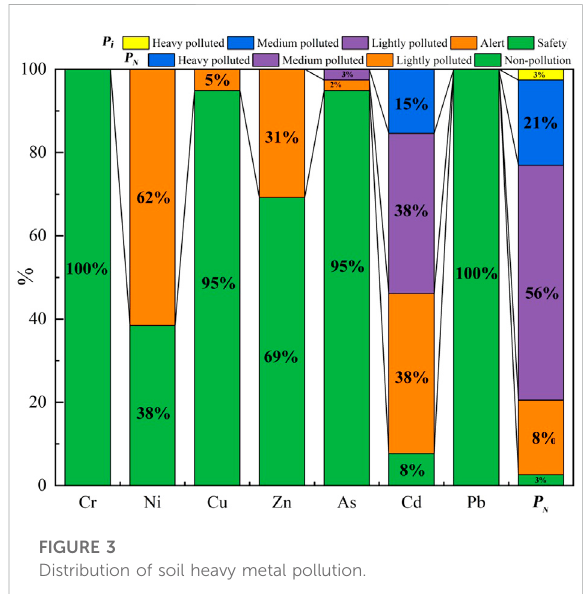
FIGURE 3 Distribution of soil heavy metal pollution.